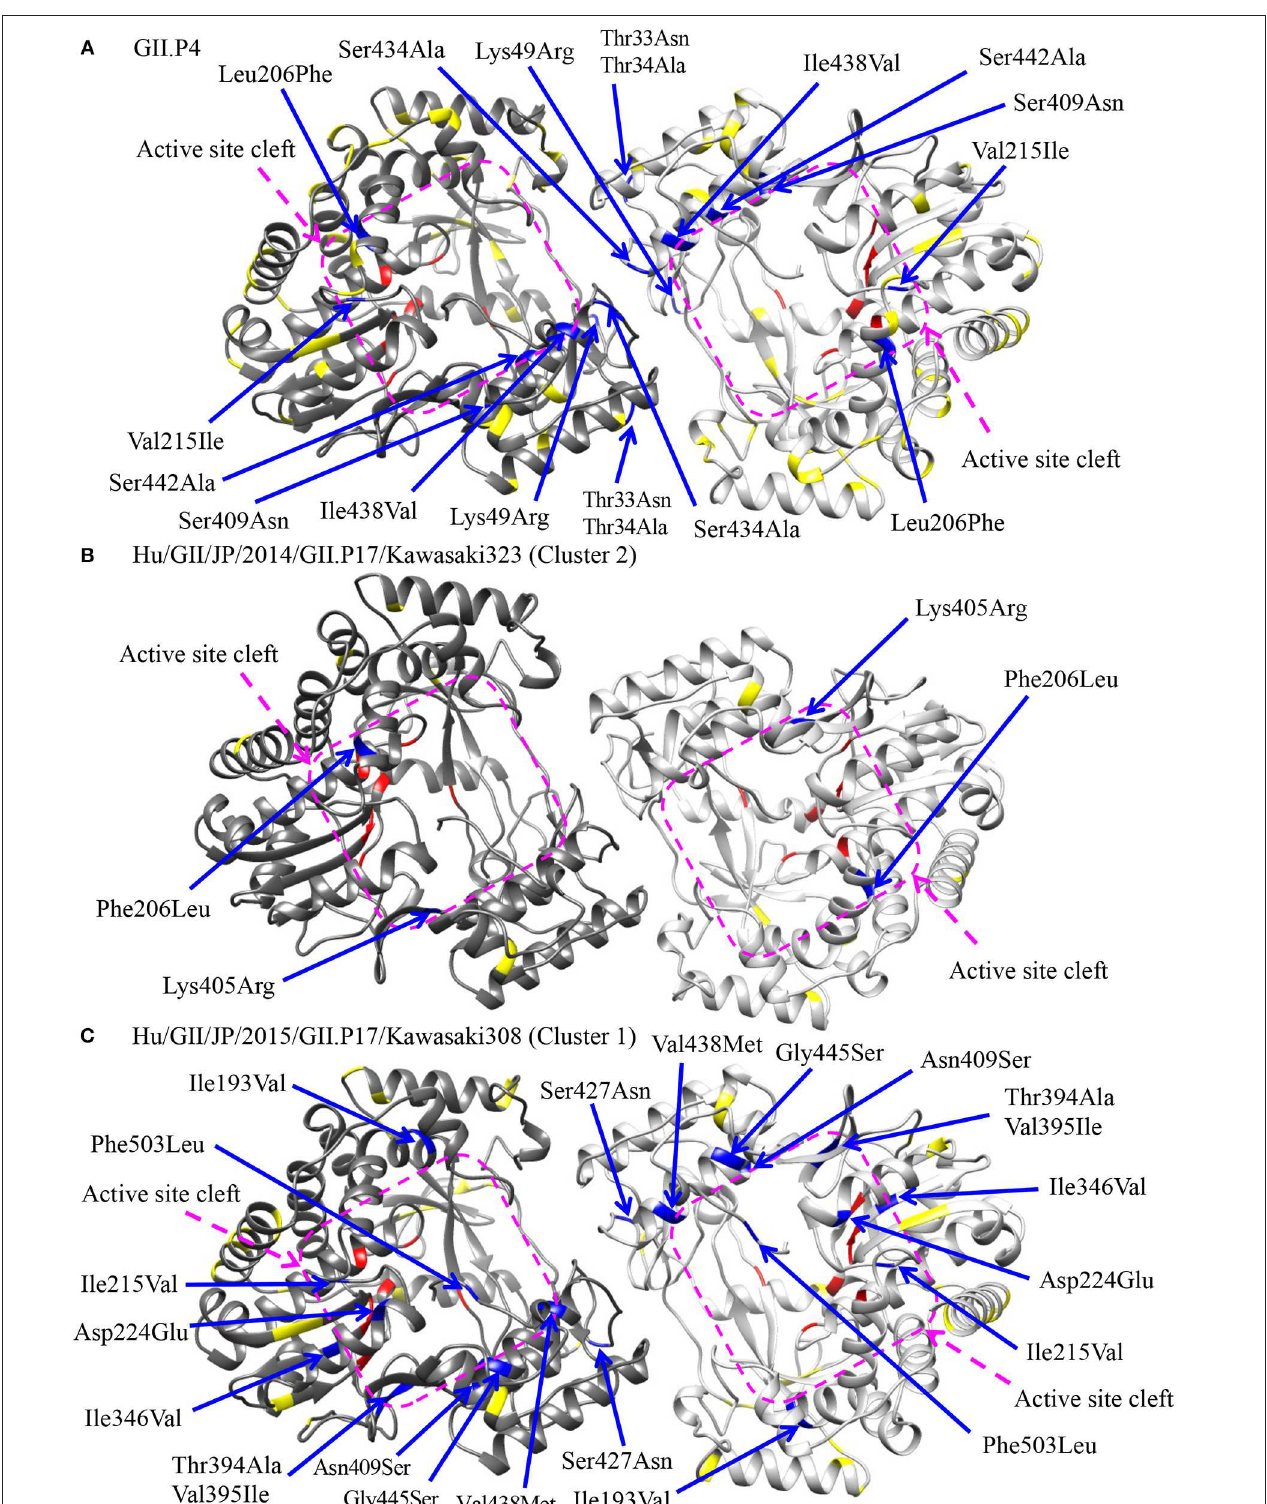
FIGURE 6 | Structural models of the RdRp protein for representative GII.P17 strains. Homodimer structures of the RdRp of GII.P4 [PDBID 1SH0; (A) ], Kawasaki323 [cluster 2; (B) ], and Kawasaki308 [cluster 1; (C) ] are shown. Each monomeric chain that compose the dimer structure are colored gray (chain A) and dim